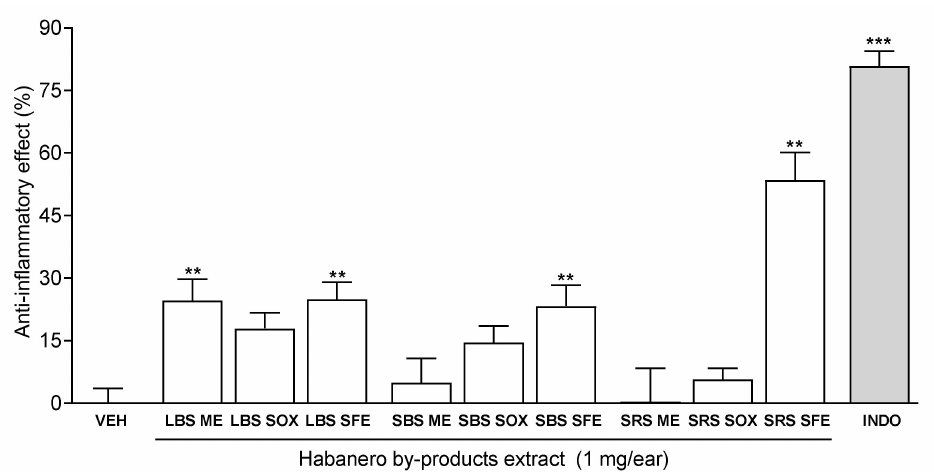
Figure 2. Anti-inflammatory effect of habanero pepper by-product extracts obtained by maceration (ME), Soxhlet (SOX) and supercritical fluid extraction (SFE). Each bar represents the mean ± SEM (n = 6–8 per group). *** p < 0.05, ** p < 0.01, different from the group treated with the vehicle (VEH), by one-way ANOVA followed by Dunnett’s test. INDO: Indomethacin was used as positive control and was applied at the dose of 1 mg · ear − 1 . LBS: Leaves from plants grow in black soil; SBS: Stems from plants grow in black soil; SRS: Stems from plants grow in red soil.